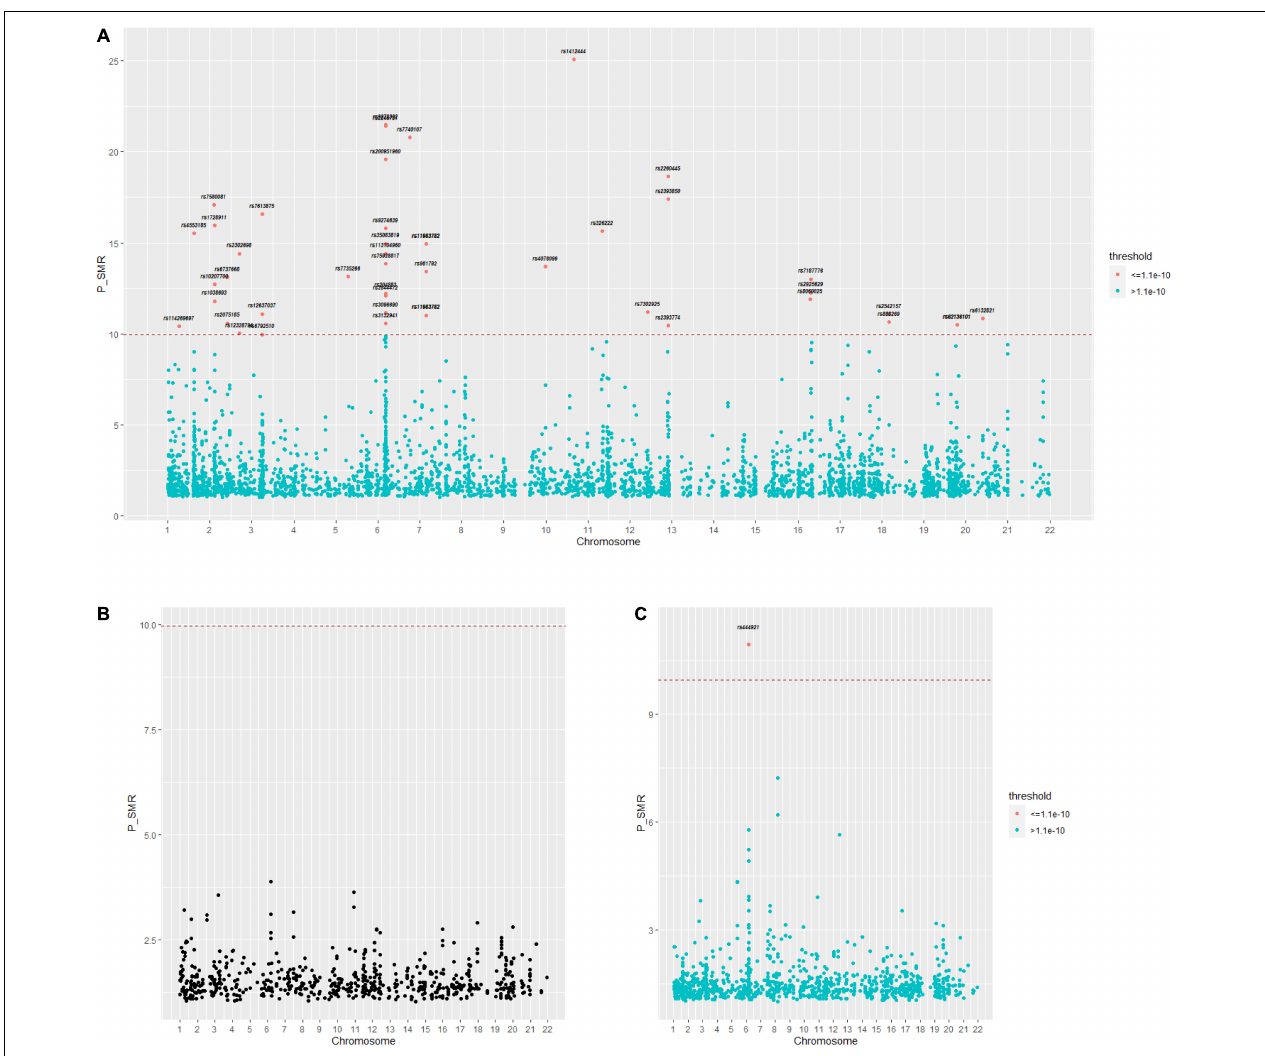
FIGURE 5 | (A–C) Distribution of p -value calculated by SMR for three GWAS datasets. GWAS, genome-wide association studies; SMR, summary data-based Mendelian randomization.